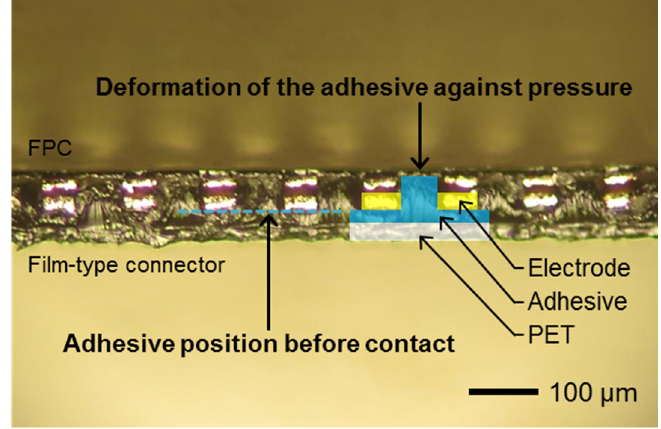
Figure 8. Cross-sectional image of the junction.